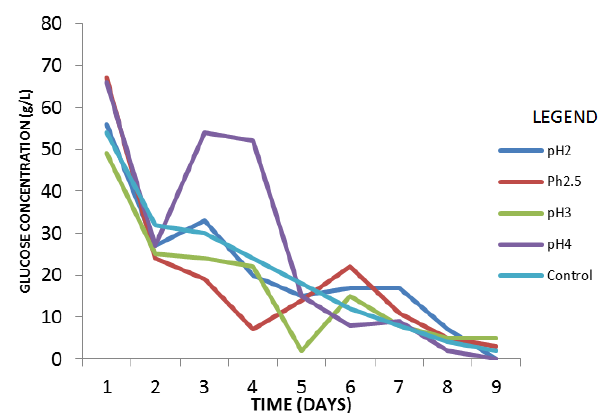
Fig. 1. Residual glucose in the fermentation at different